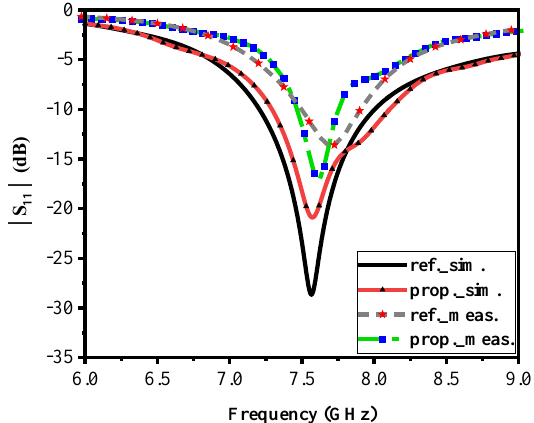
| of the reference and the proposed 11